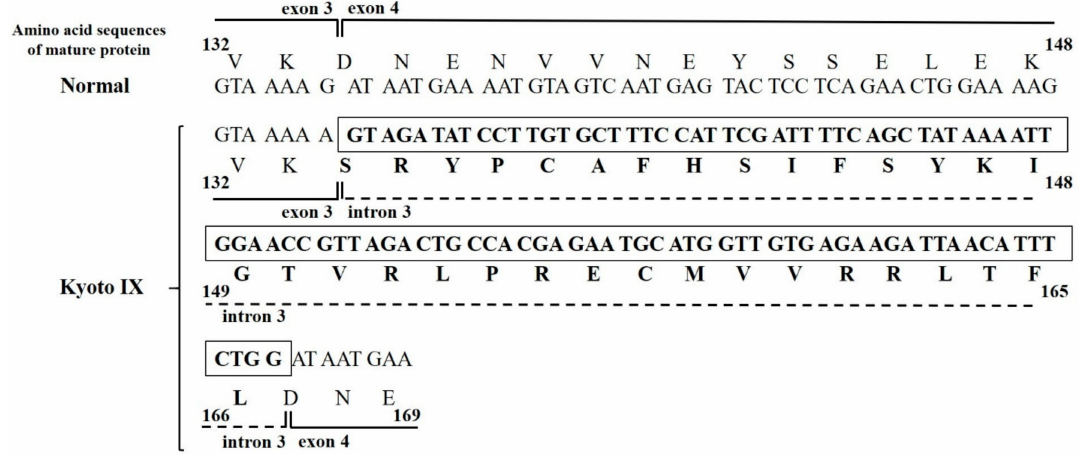
Figure 3. Predicted amino acid sequences for the mature protein of the Kyoto IX propositus. The aberrant amino acid sequences of B β -combined with exon 3, intron 3, and exon 4 are indicated. Bold letters in the box indicate aberrant nucleotide sequences and bold letters without the box indicate aberrant amino acid